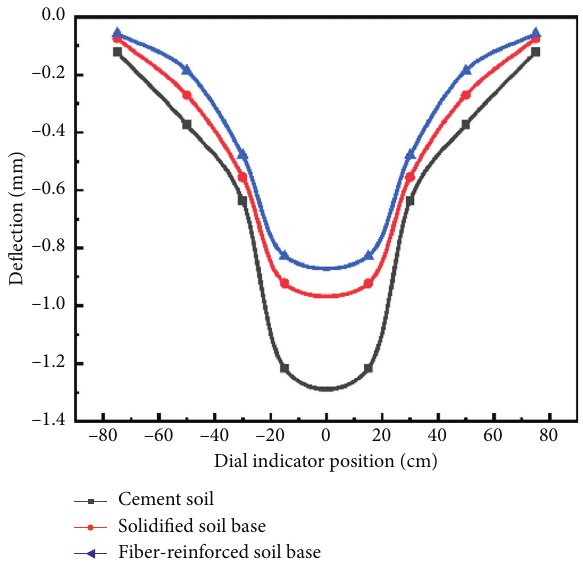
Figure 21: Deflection basins.